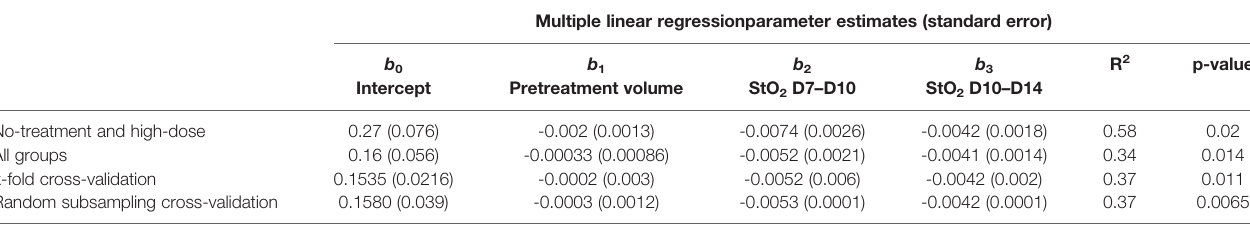
Size groups used were n = 15 and 29 for no-treatment and cabozantinib and all mice respectively. Forthek-fold cross-validation, k =5was usedtorepresentthenumber ofgroupsallmice were split into.Lastly, random subsampling cross-validation(N=100repeats)consisted of80% training data and 20% validation